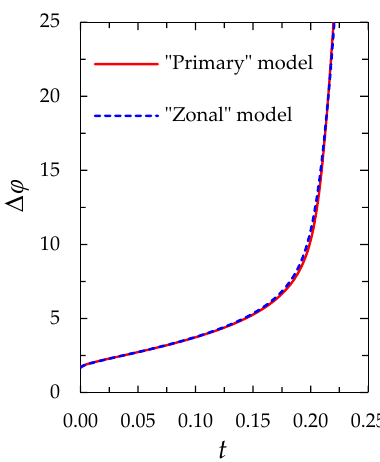
Figure 4. Chronopotentiograms of a CEM at i/i lim = 2, ε = 3 × 10 − 7 . The solid line is calculated using the “primary” model; the dashed line, using the “zonal” model.